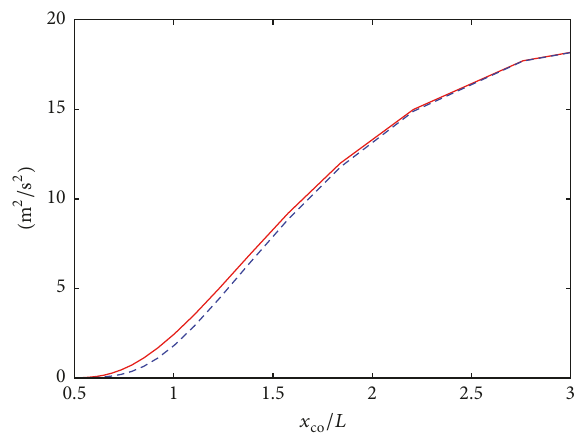
Figure 2: Amplitude of spatial variation of benchmark 𝜎 2 𝑎 (𝑥) , defined by max 𝜎 2 𝑎 (𝑥) − min 𝜎 2 𝑎 (𝑥) , plotted by red solid curve as a function of Δ𝑥 co /𝐿 . Amplitude of spatial variation of estimated 𝜎 2 (𝑥) , defined by max 𝜎 2 (𝑥) − min 𝜎 2 (𝑥) and plotted by blue 𝑎 ∗ 𝑎 ∗ 𝑎 ∗ dotted curve as a function of Δ𝑥 co /𝐿 .